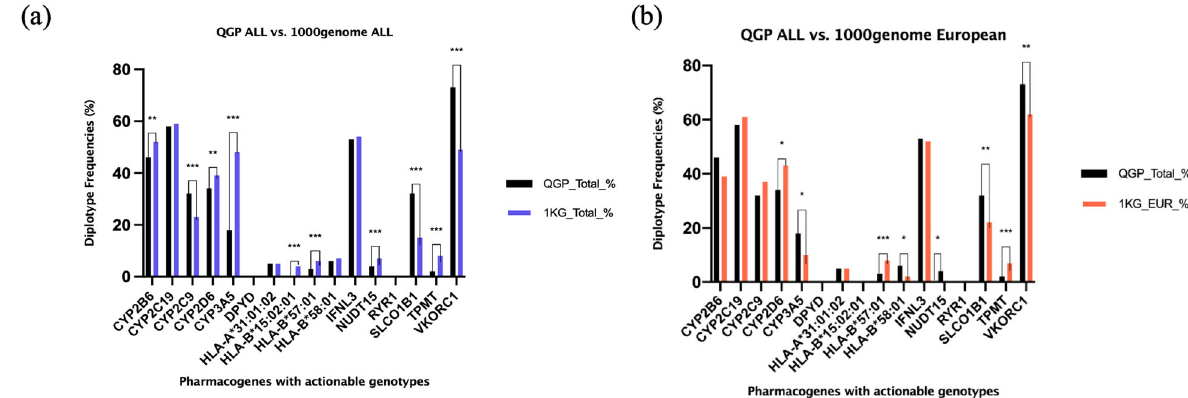
Fig. 1 Comparison of actionable genotype or diplotype frequencies in the Qatari population. Actionable frequencies are compared between the Qatari cohort ( n = 6045) and ( a ) the overall 1000 genomes cohort ( n = 2504), or ( b ) the European superpopulation in the 1000 genomes cohort ( n = 503). p values of signi fi cantly differing frequencies with Bonferroni adjustment indicated as follows: * = 0.0001 ≤ p value < 0.05, ** = 0.000001 < p value < 0.0001, *** = p value ≤